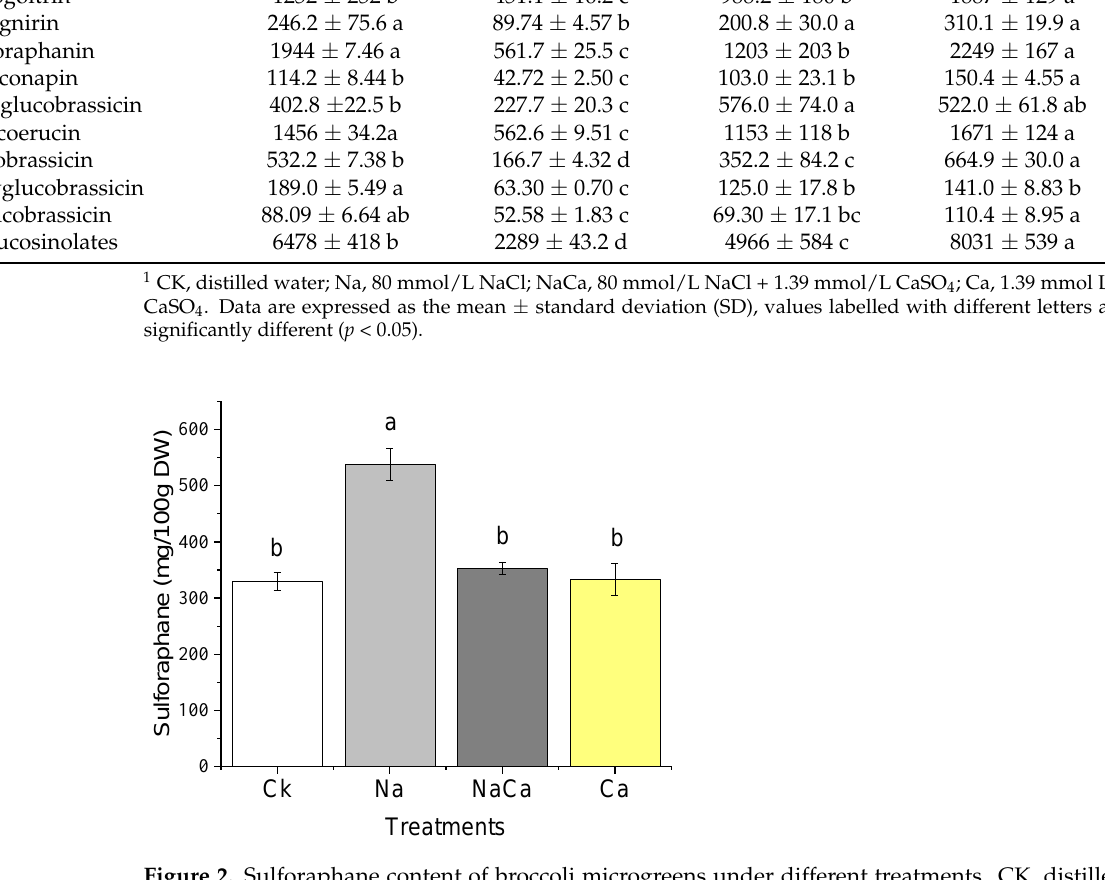
Figure 3. Nitrate content of broccoli microgreens under different treatments. CK, distilled water; Na, 80 mmol/L NaCl; NaCa, 80 mmol/L NaCl + 1.39 mmol/L CaSO 4 ; Ca, 1.39 mmol/L CaSO 4 ; DW, dry weight. Data are expressed as the mean ± standard deviation (SD), values labelled with different letters are significantly different ( p < 0.05).